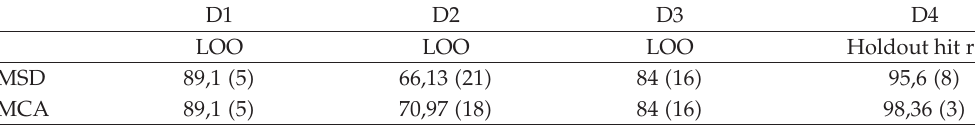
Table 3: LOO hit rates and the holdout hit rates for MCA and MSD models.